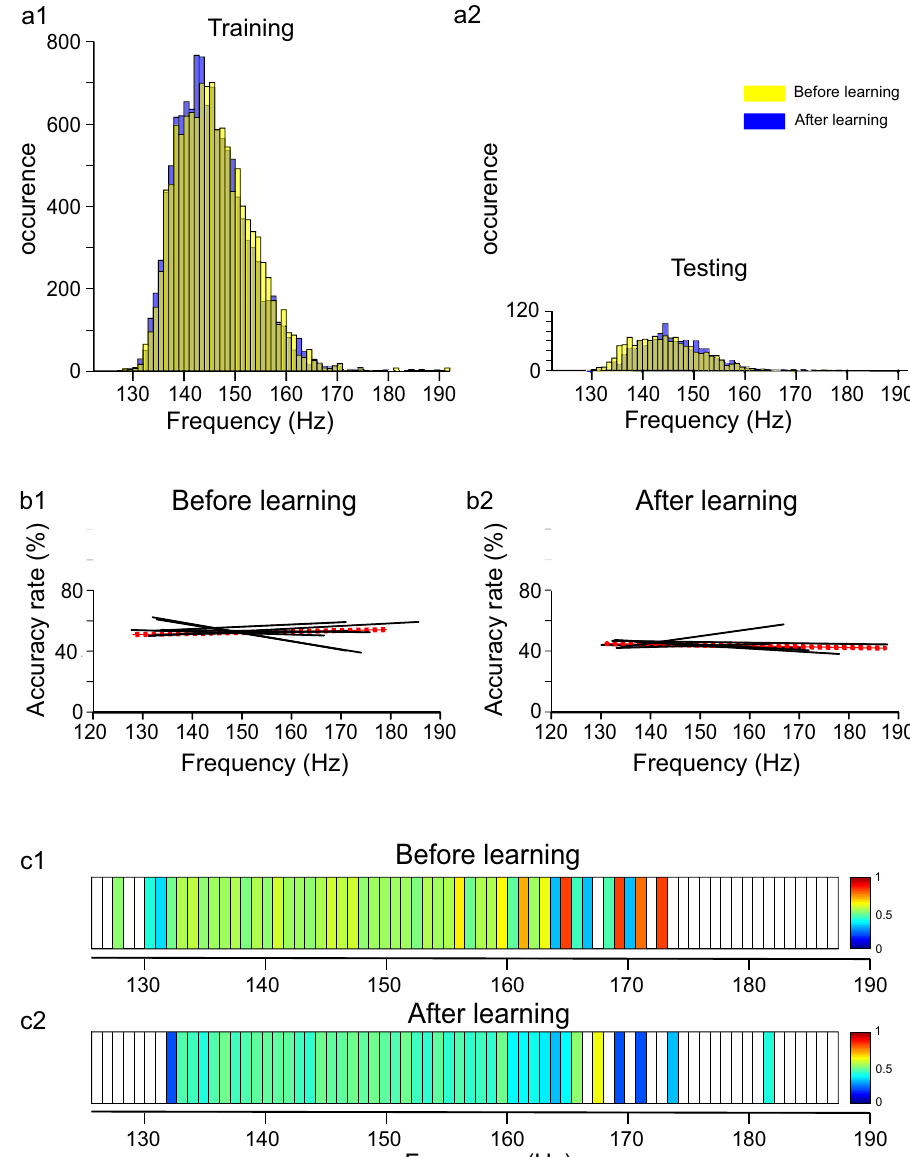
Figure 4. Accuracy rate of RCIs is not correlated with the intrinsic frequency of SWRs in the APP/PS1 mice. The SWRs’ frequency had similar distribution before and after learning both in the training ( a1 ) and testing pools of RCIs ( a2 ) and was correlated with RCI’s accuracy rate neither in individual animals ( b1-2 ) nor in the pooled set of RCIs ( c1-2 ). Notice flat regression lines in b1-2 and the color code bars in c1-2 indicating an accuracy rate close to 50% independently on SWR’s frequency. Other abbreviations as in Fig.